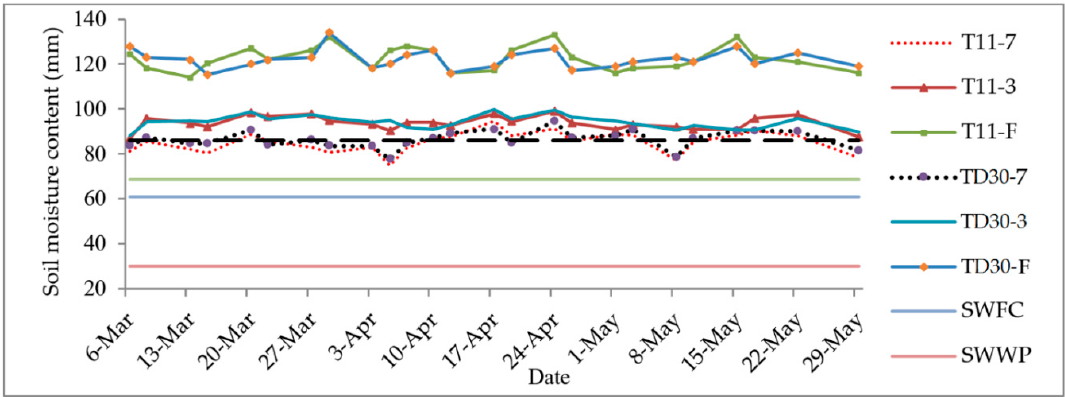
Figure 1. Soil moisture content in different irrigation regimes during the crop production cycle.